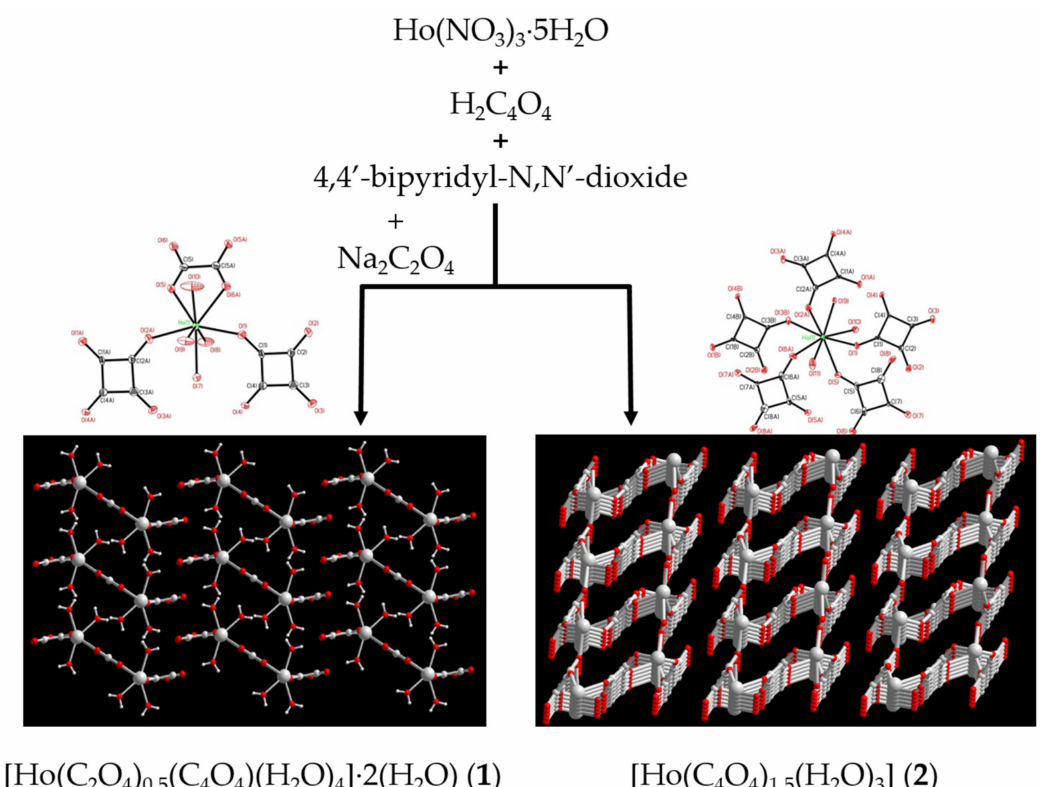
Scheme 2. Synthetic representation of compounds 1 and 2 (red for O atom, and gray-white for Ho and C